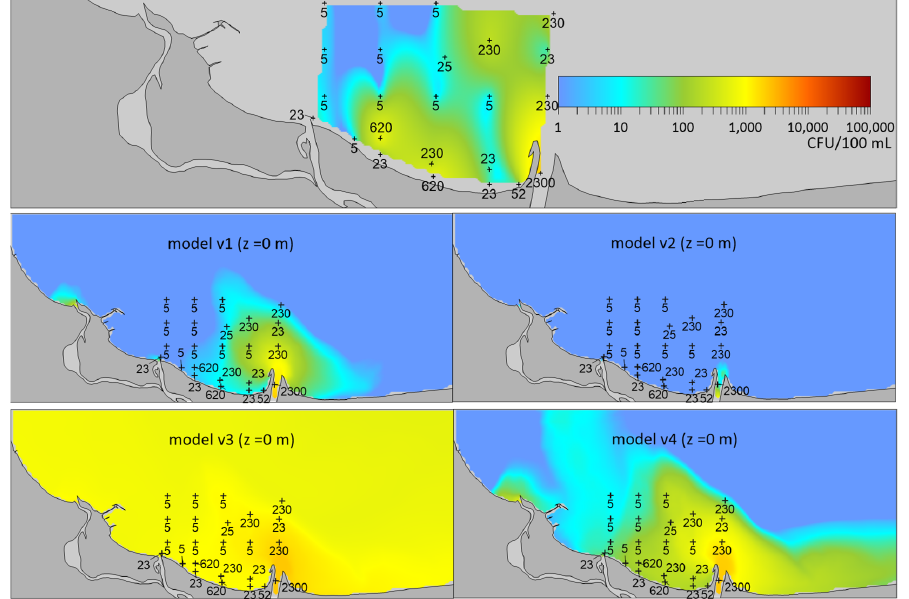
Figure 1. Comparison of E. coli concentrations observed on 29 May 2003 ( top panel) and modeled with the use of different formulas for bacterial survival (versions: v1, v2, v3, v4, see Table 3).